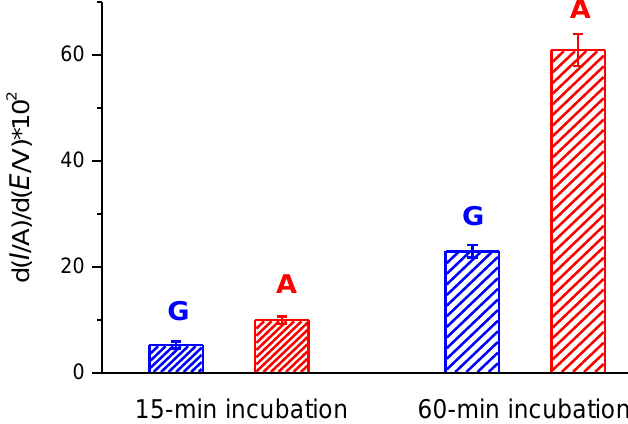
Figure 5. The current intensities of the differentiated DPV peaks for electrooxidation of the guanine (blue) and adenine (red) residues after incubation of a 30 µ g / ml dsDNA solution on the SPE / (P n BMA 40 - b -PDMAEMA 120 + MWCNT_2) construct for 15 or 60 min.